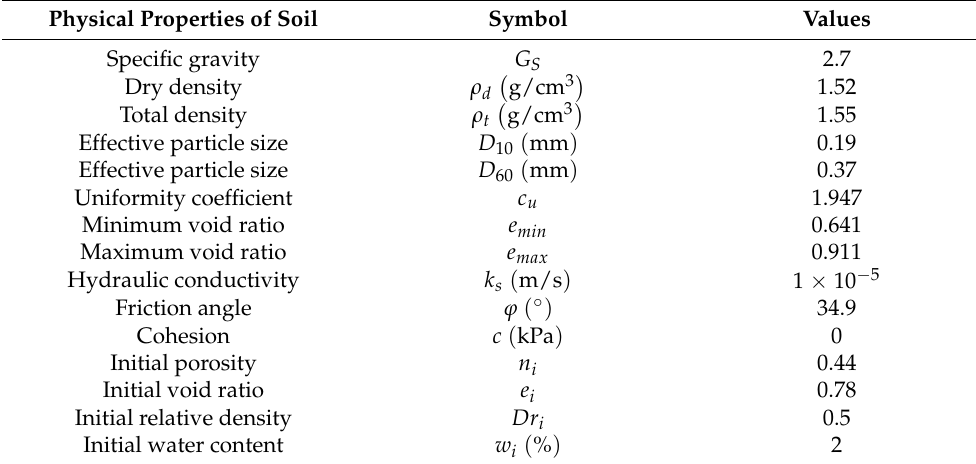
Table 1. Basic physical properties of the Drava River sand built-in in the model and initial conditions at the start of the tests.